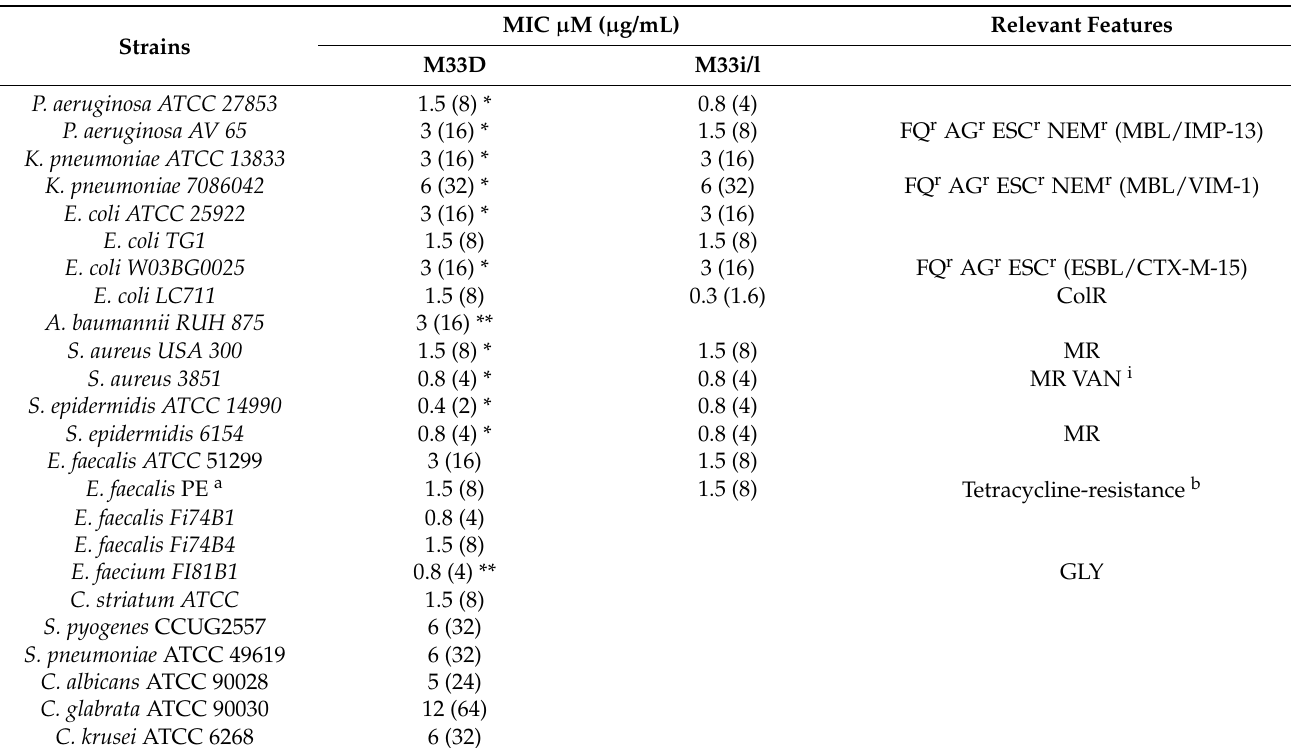
Table 1. MIC of M33d and M33i/l against bacterial strains representative of various pathogenic species, including MDR strains of clinical